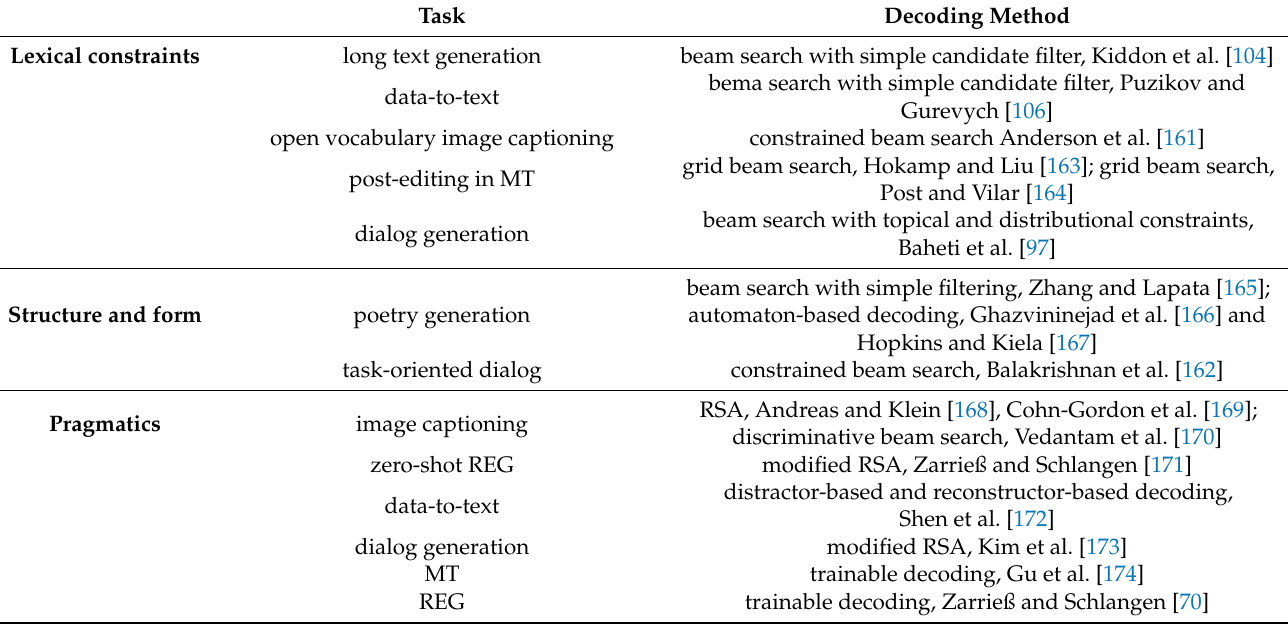
Table 5. Overview of papers on decoding with linguistic constraints (Section